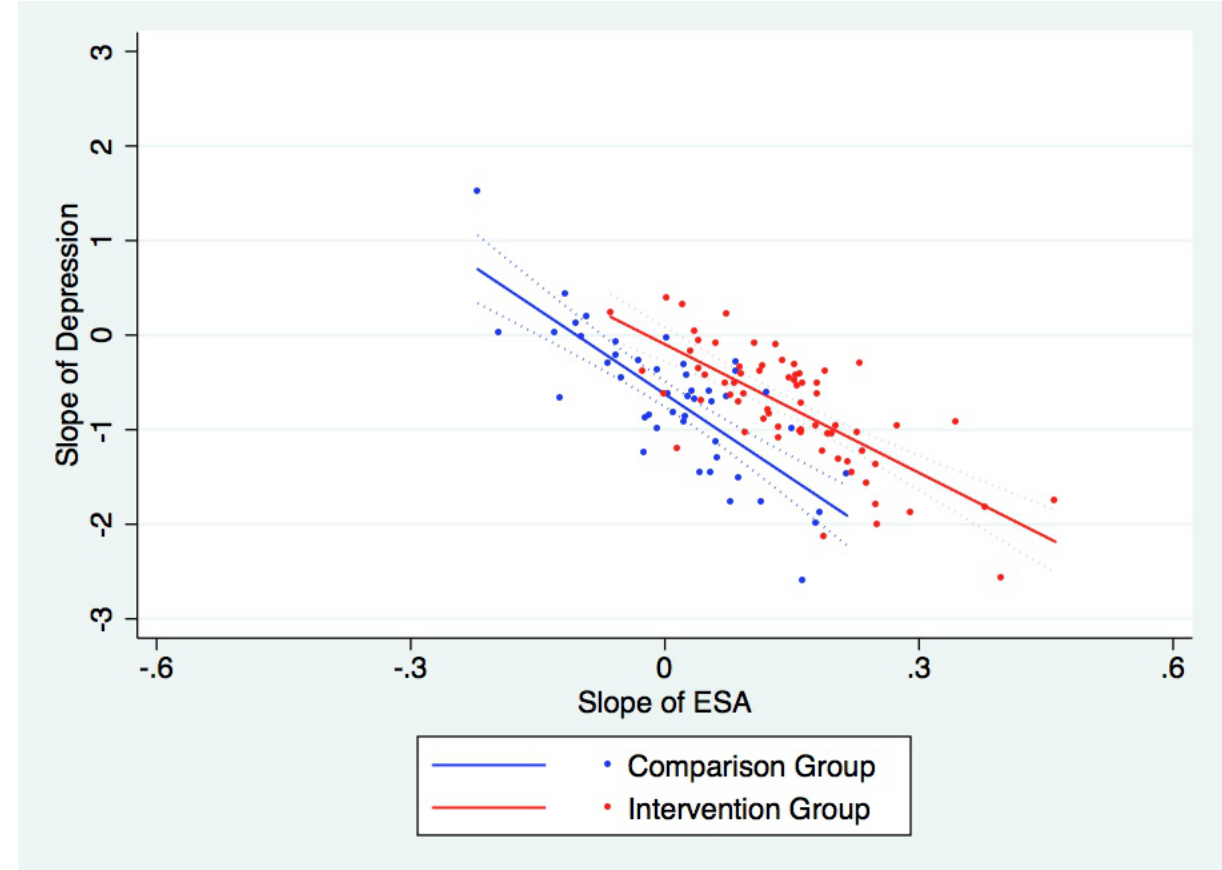
Figure 3. The relationship between self-monitoring, the slope of depressive symptoms, and the slope of emotional self-awareness (ESA). The points represent individuals' estimated slopes and the lines represent the line of best fit with 95% confidence